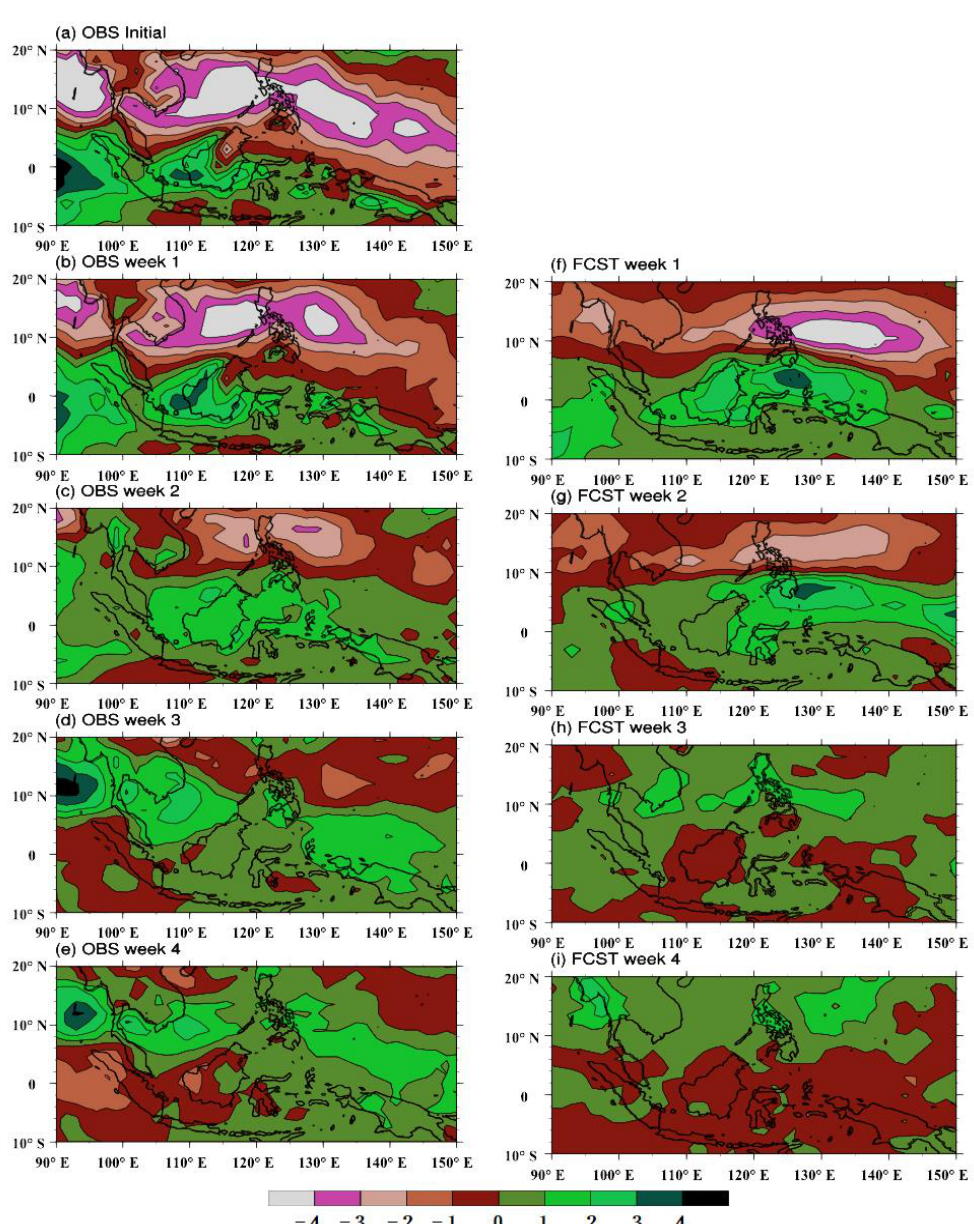
Figure 8. Composite observation (left panels) and (median MME) forecast precipitation anomalies (mm/day) from initial conditions of BSISO1 phase 1. ( a ) Observed initial conditions, ( b – e ) observed average for weeks 1 – 4, and ( f – i ) forecast average for weeks 1 – 4.